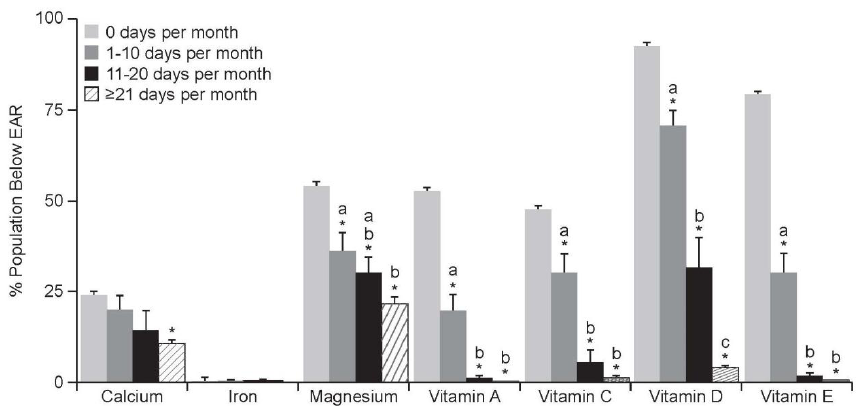
Figure 2. Proportion of subjects ≥19 years of age achieving an intake of shortfall nutrients below the EAR from food + MVMS by frequency of intake. Reprinted from Blumberg, J.B., et al. [3]. Abbreviations: EAR: Estimated Average Requirement; MVMS: multivitamin/multimineral supplement. * p < 0.01 versus 0 days per month; a,b,c Values by frequency of MVMS use with different superscripts are significantly different ( p <